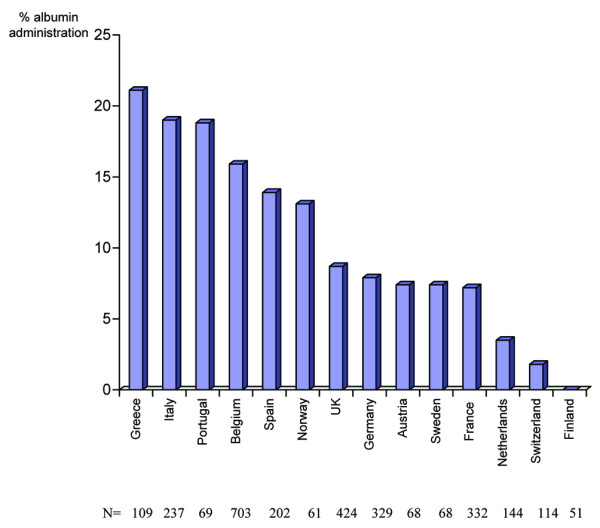
Bar chart representing the percentage of patients receiving albumin infusions in the various contributing countries. Only countries that included more than 50 patients are considered.